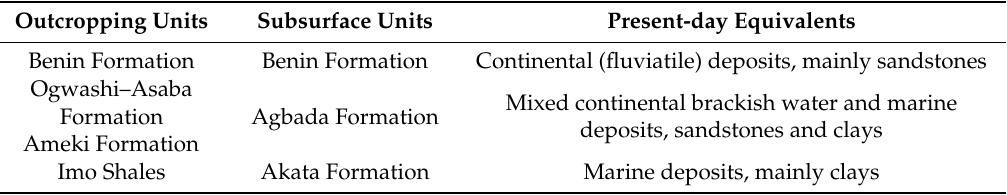
Table 1. Stratigraphic Units of the Niger Delta basin